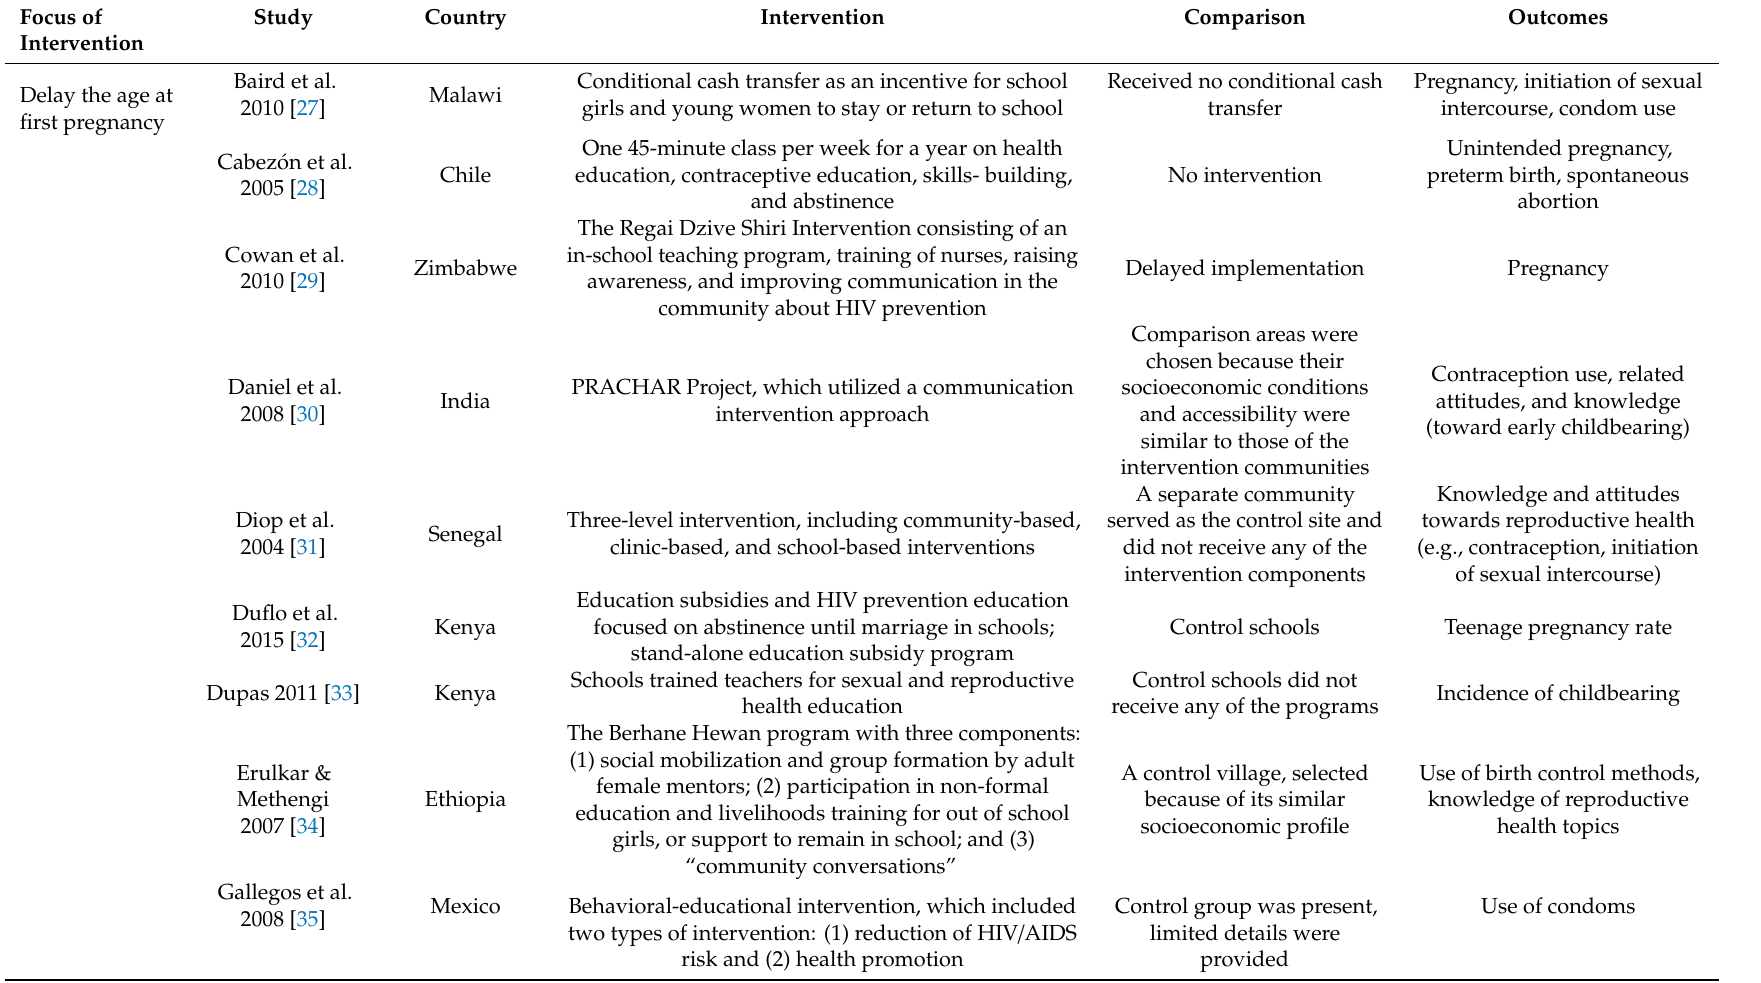
Table 1. Characteristics of included studies divided by focus of